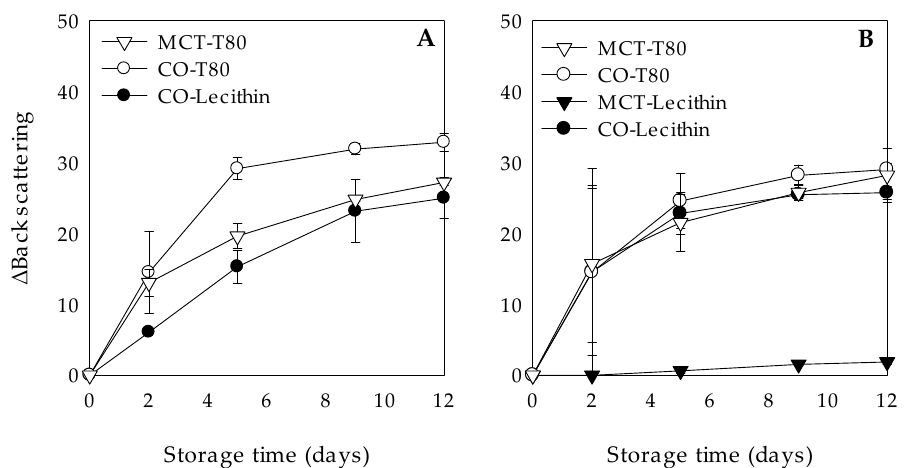
Figure 4. Clarification, expressed as variation of back scattering ( ∆ BS), at 25 ◦ C during 12 days of light exposure of chlorophyllin-loaded W 1 /O/W 2 emulsions formulated with different lipid phases consisting on medium chain triglyceride (MCT) or corn oil (CO) and without ( A ) or with ( B ) glyceryl stearate (GS) as well as different hydrophilic surfactants (Tween 80 (T80) or Lecithin).